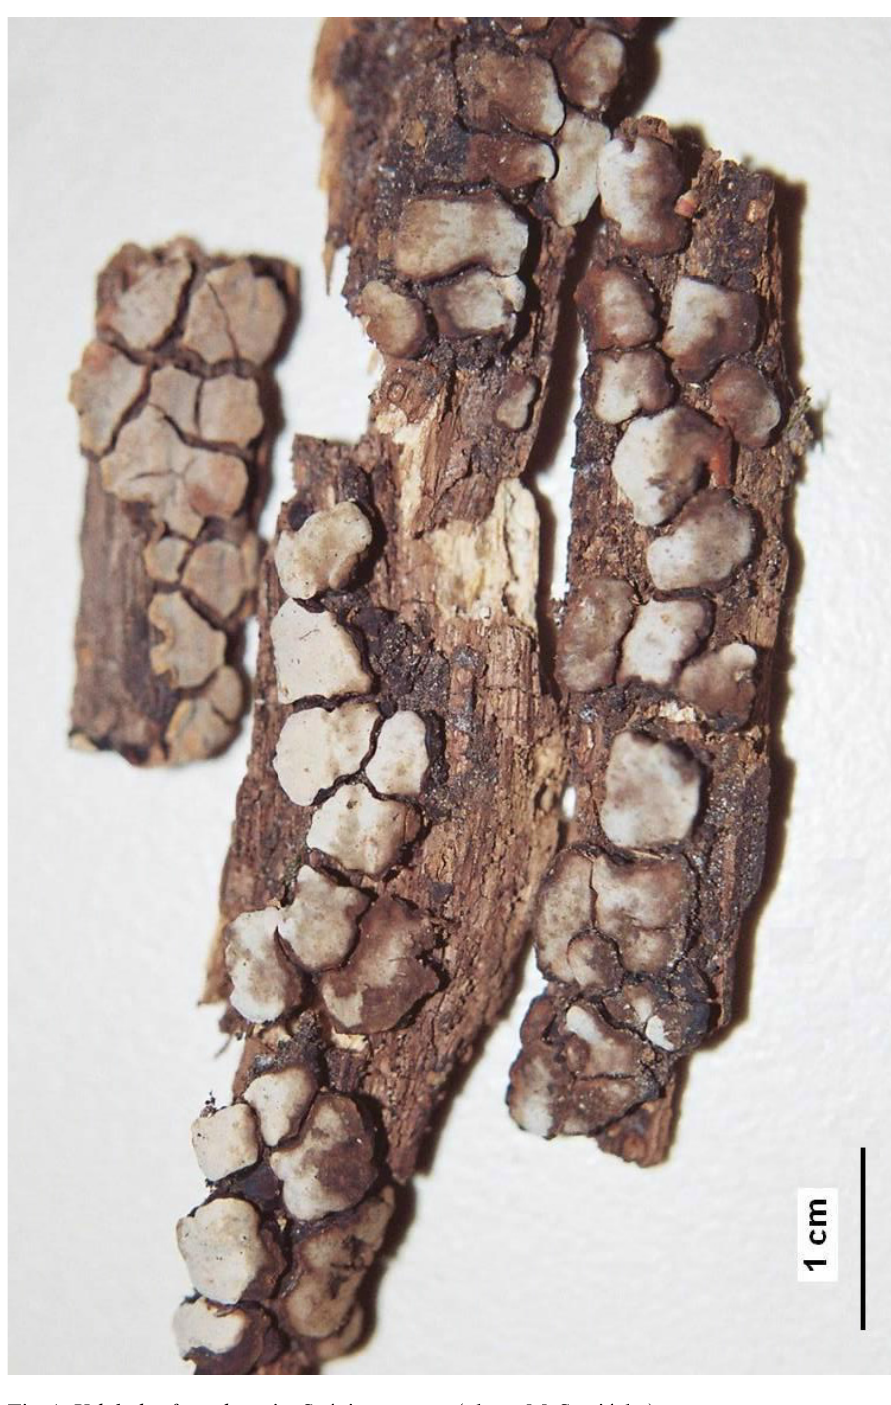
Fig. 1. Xylobolus frustulatus in Sośnica reserve (photo M.